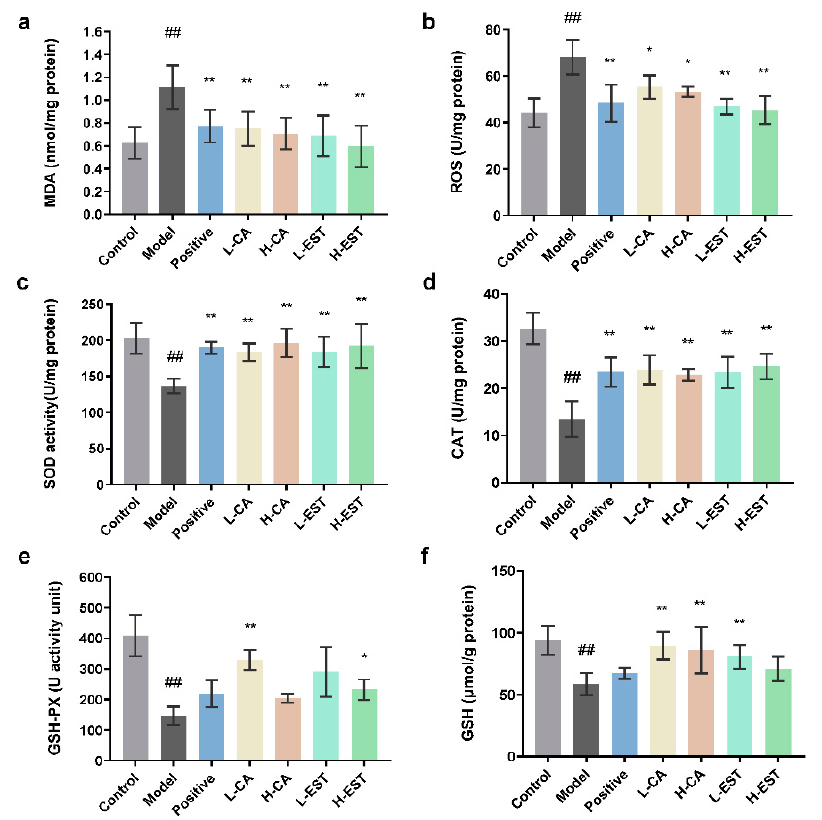
Figure 3. ( a ) MDA, ( b ) ROS level, ( c ) SOD, ( d ) CAT, ( e ) GSH-Px activities, and ( f ) GSH content of liver tissues in each group. Data are expressed as mean ± SD of at least three independent experiments ( n ≥ 5). ## p < 0.01 compared with the control group; * p < 0.05, ** p < 0.01 compared with the model group.